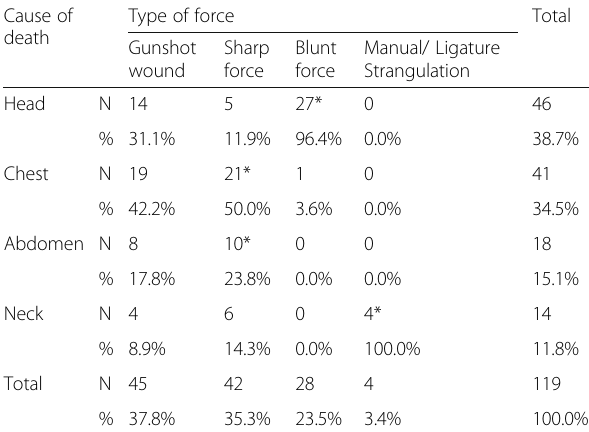
Table 3 Cause of death categorized by type of force and location